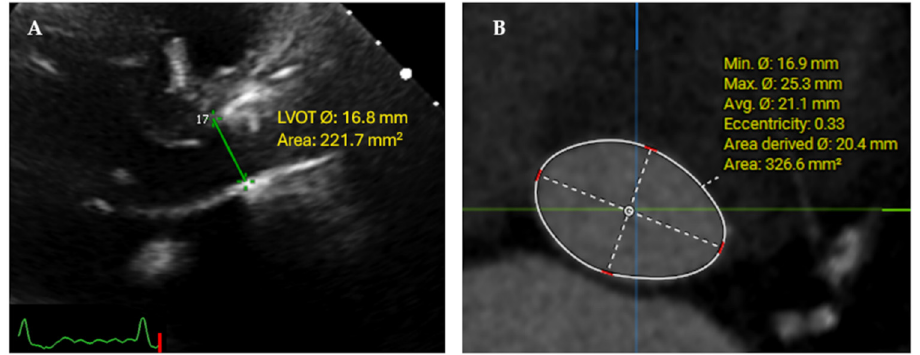
Figure 1. LVOT measurements: ( A ) 2D-TTE LVOT diameter measurements from the parasternal long axis zoomed view in mid-systole, ( B ) MDCT multiplanar reconstruction of the LVOT (5 mm below the annular plane, in mid-systolic phase 30%) with the minimum (anteroposterior) diameter and the maximum (medio-lateral) diameter with measured 3D-LVOT area, with a larger area calculated from the MDCT measured minimum and maximum diameters with eccentricity index of